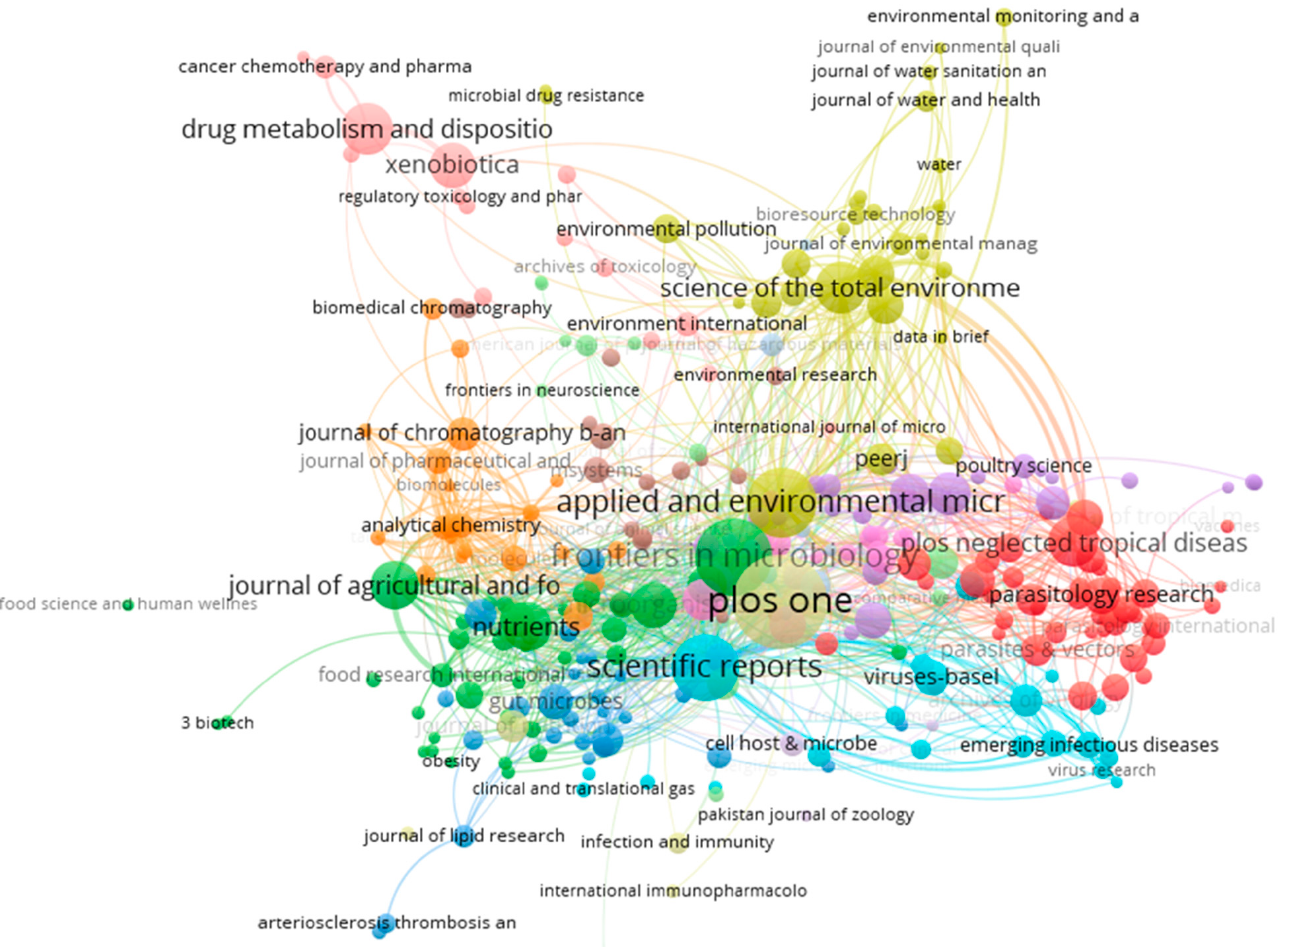
Figure 11. Network visualization map of journals with a minimum of 5 publications related to resource recovery from human and animal waste (2007–2022).